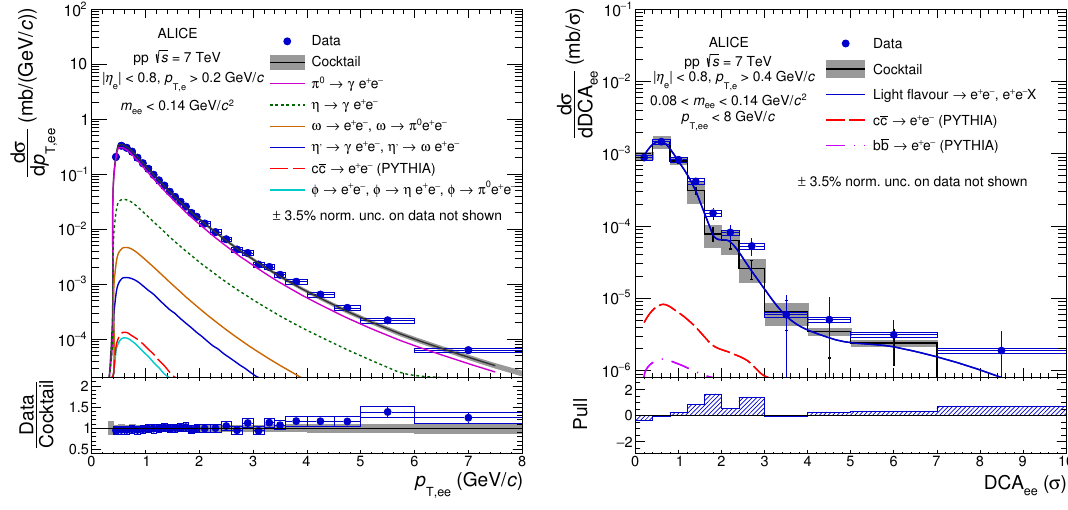
p s = 7 TeV in the